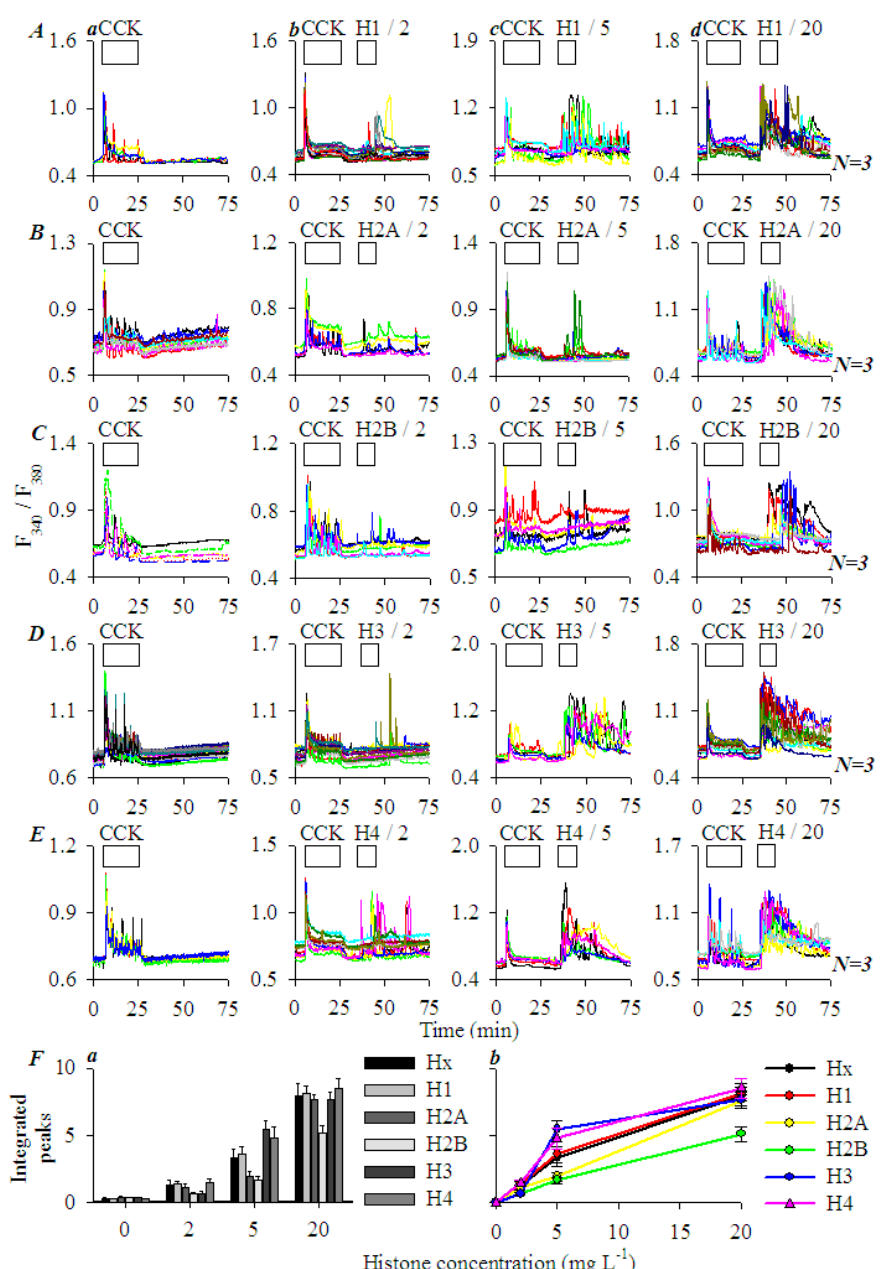
Figure 3. H1, H2A, H2B, H3, and H4 induced calcium oscillations in AR4-2J cells with varied efficacies. Fura-2-loaded AR4-2J were perifused; CCK 20 pM, H1 ( A ), H2A ( B ), H2B ( C ), H3 ( D ), H4 ( E ) at 0 ( a ), 2 ( b ), 5 ( c ), 20 ( d ) mgL − 1 (from left to right in each panel) were added as indicated by the horizontal bars ( N = 3). Integrated histone response (area under calcium peaks above the basal level from 35–75 min) was plotted against histone concentrations for each histone, either in bar graphs ( Fa ) or curves ( Fb ).